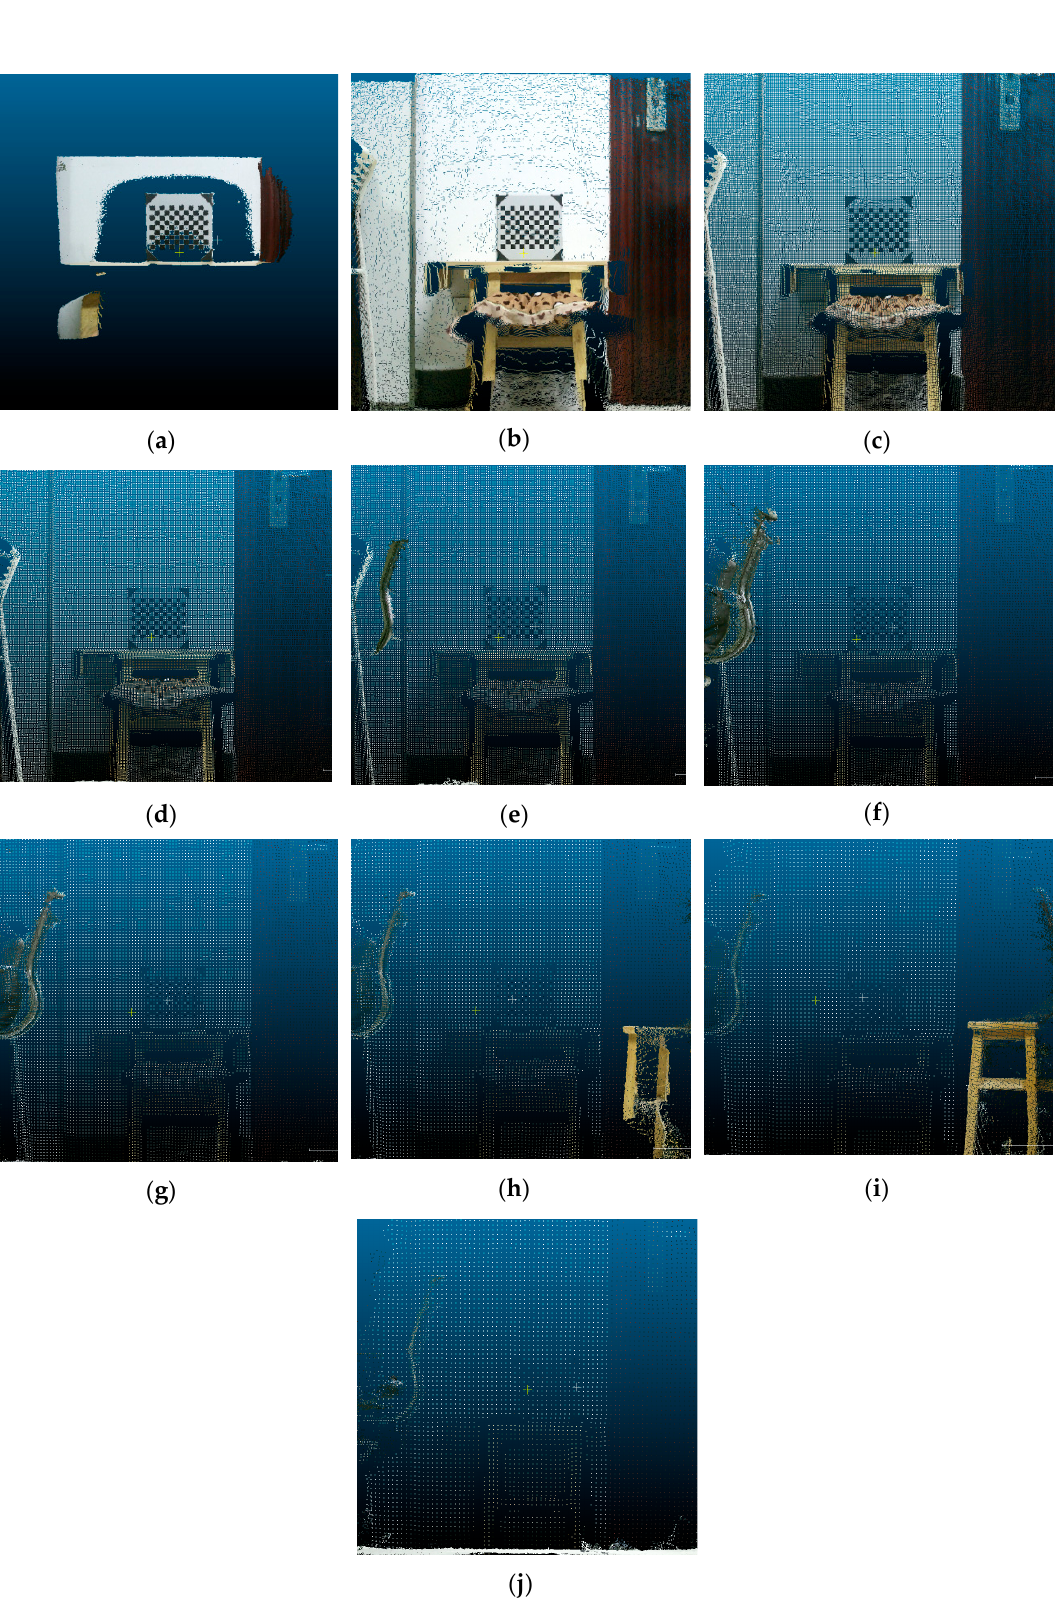
Figure 6. Checkerboard data collected at different distances. ( a ) 500 mm; ( b ) 1000 mm; ( c ) 1500 mm; ( d ) 2000 mm; ( e ) 2500 mm; ( f ) 3000 mm; ( g ) 3500 mm; ( h ) 4000 mm; ( i ) 4500 mm; and ( j ) 5000 Table 2. Compensation effect of the optimal model on the checkerboard at different distances.